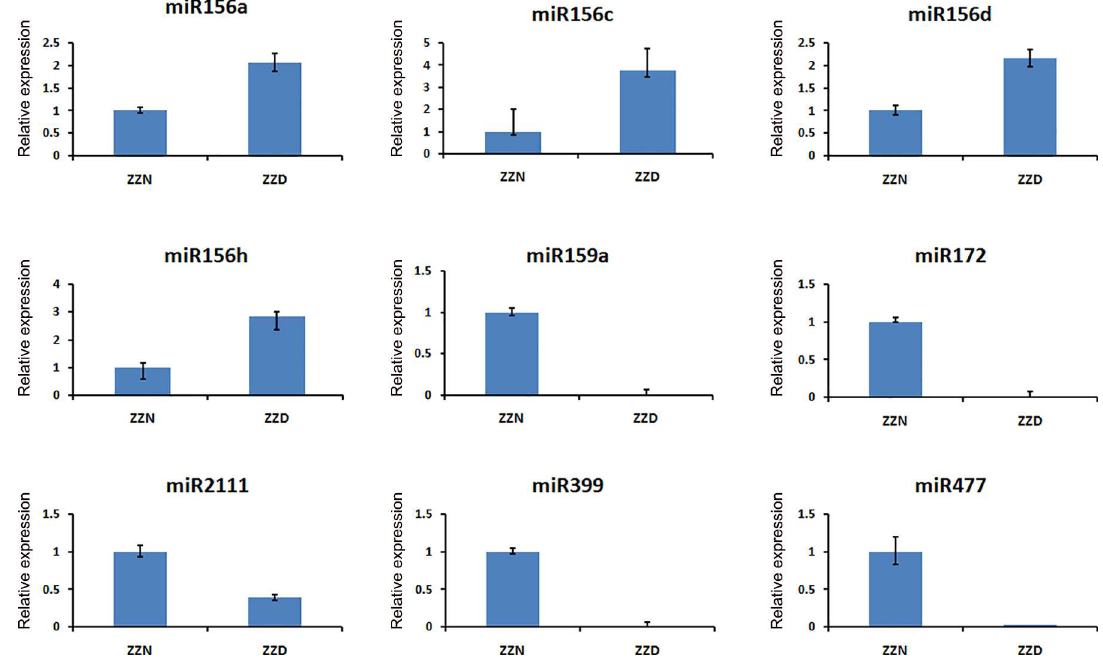
Fig 4. qRT-PCR validation of the differentially expressed miRNAs. Fold changes of the differentially expressed miRNAs are shown. miRNAs were analyzedusing the poly(T) adaptor RT-PCR method. The levels in ZZN were arbitrarily set to 1. Error bars represent the standard deviationsof three technical PCR